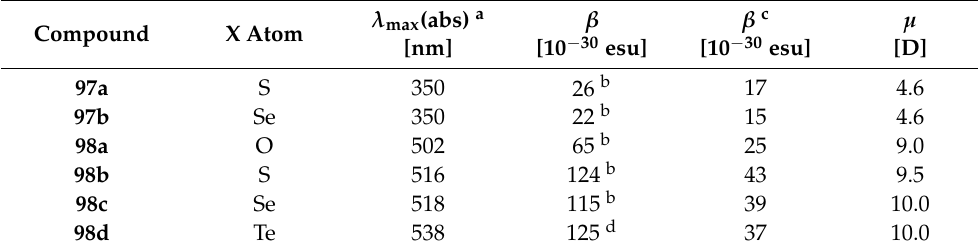
Figure 15. Chalcogen effect in the thieno[3,2- b ]thiophene push – pull derivatives 97 and 98 . Table 11. The (non)linear optical properties of derivatives 97a – b and 98a – d .